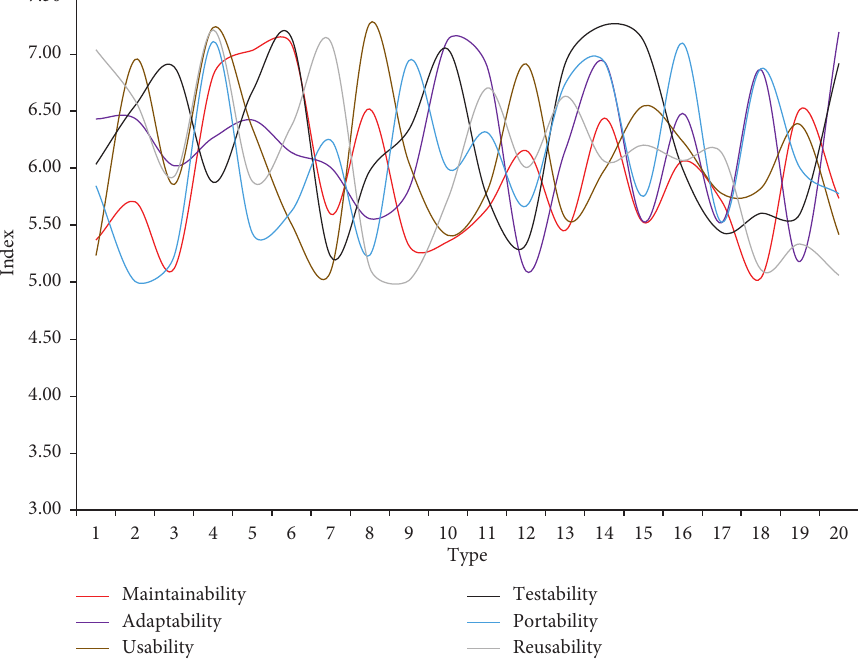
Figure 6: Performance of alumina ceramic